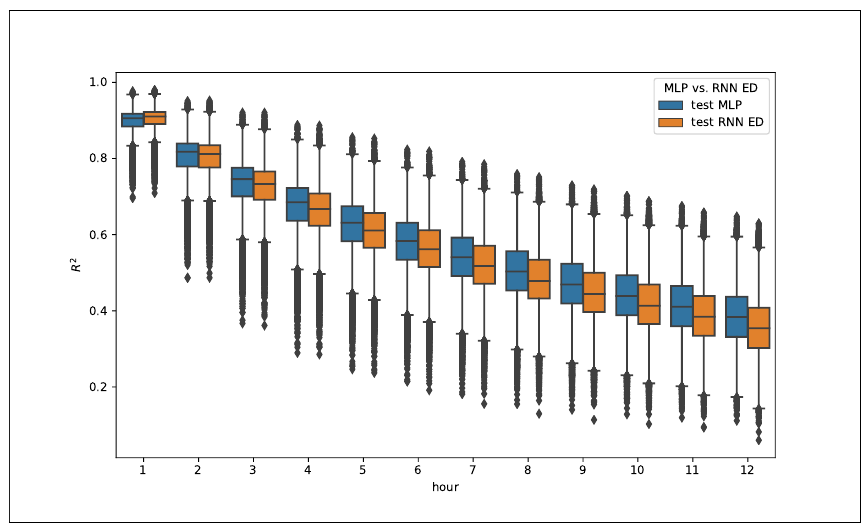
Figure 7. Boxplot comparing the hourly distribution of R 2 error results between the MLP and RNN ED